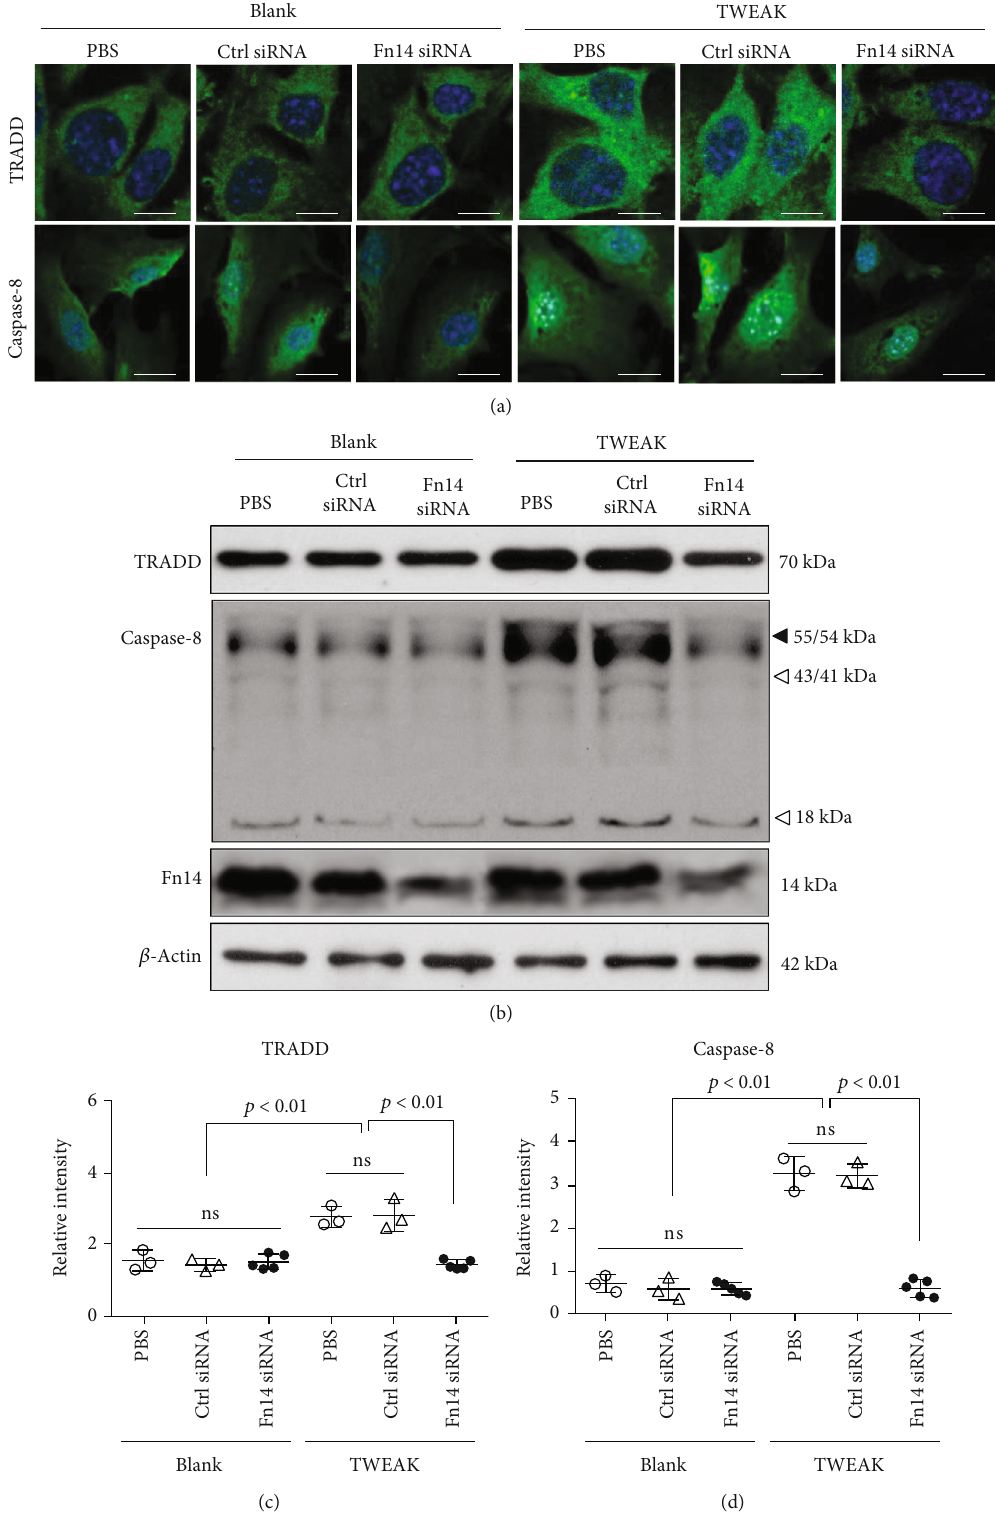
Figure 5: The e ff ect of TWEAK/Fn14 interaction on TNFR1-dependent downstream signals in normal keratinocytes. Primary human keratinocytes were cultured in vitro and then received 48h stimulation with TWEAK (100ng/ml). Some cells were pretransfected with Fn14 or control siRNA. (a) The expression of TRADD and caspase-8 was analyzed in cells via immuno fl uorescent staining. (b) The expression of TRADD and caspase-8 was detected in cell lysates via Western blot. (c, d) The band intensities of Western blots were measured with ImageJ software. Data were obtained from fi ve independent experiments. Representative images are shown. Scale bar = 5 μ m . ns: not signi fi